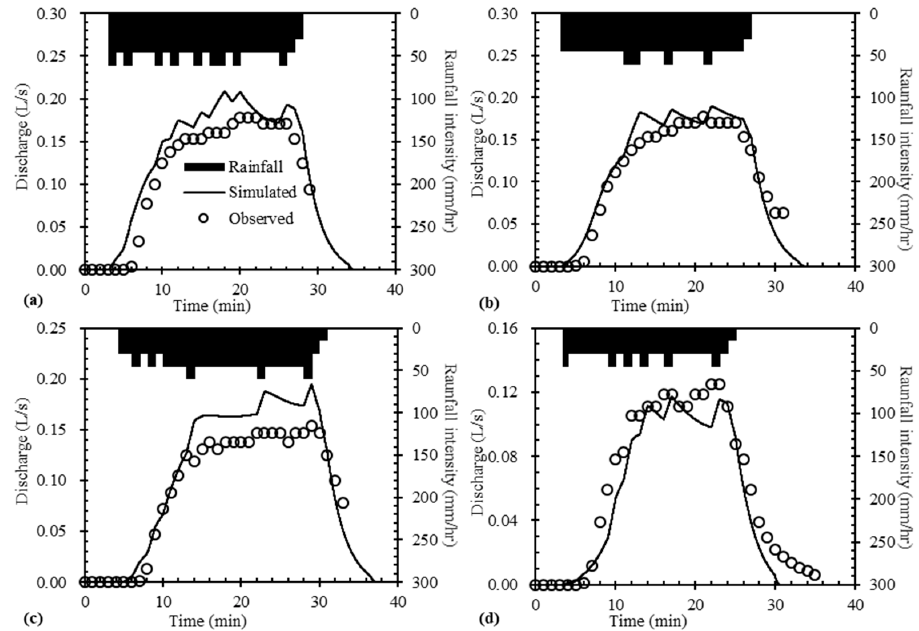
Figure 5. Simulated and observed hydrographs of one pervious surface under four events: ( a ) S01R1, ( b ) S01R2, ( c ) S01R3, and ( d ) S01R4 (Table 2).